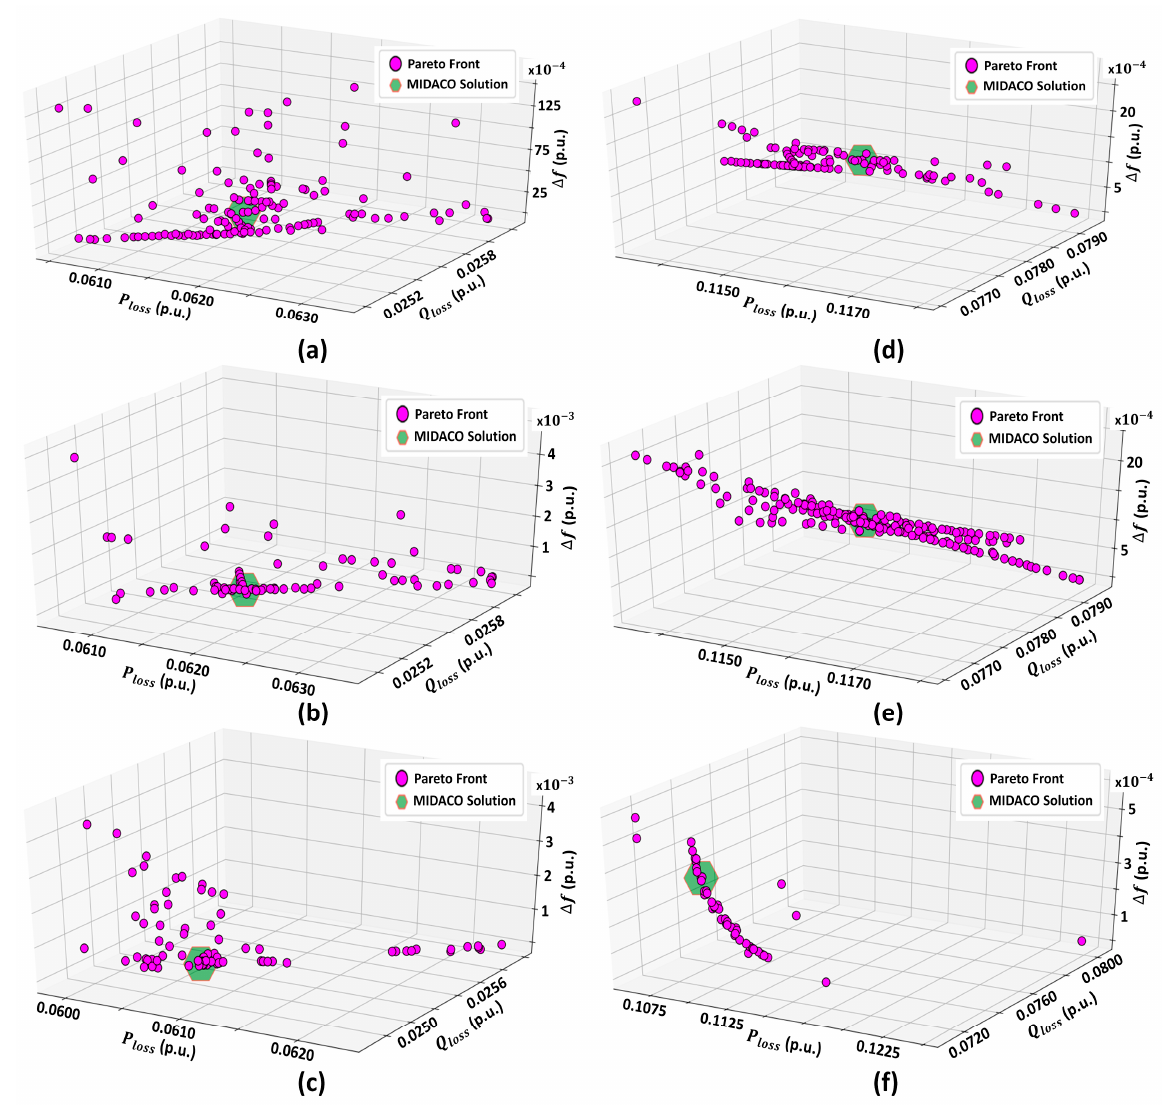
Figure 9. Many-objectives Pareto front considering different load-flow methods; the optimal solu- tion is highlighted with the green shape for ( a ) SBFS in 69-bus, ( b ) SBFS-II in 69-bus, ( c ) GBFS in 69- bus, ( d ) SBFS in 118-bus, ( e ) SBFS-II in 118-bus, and ( f ) GBFS in 118-bus.